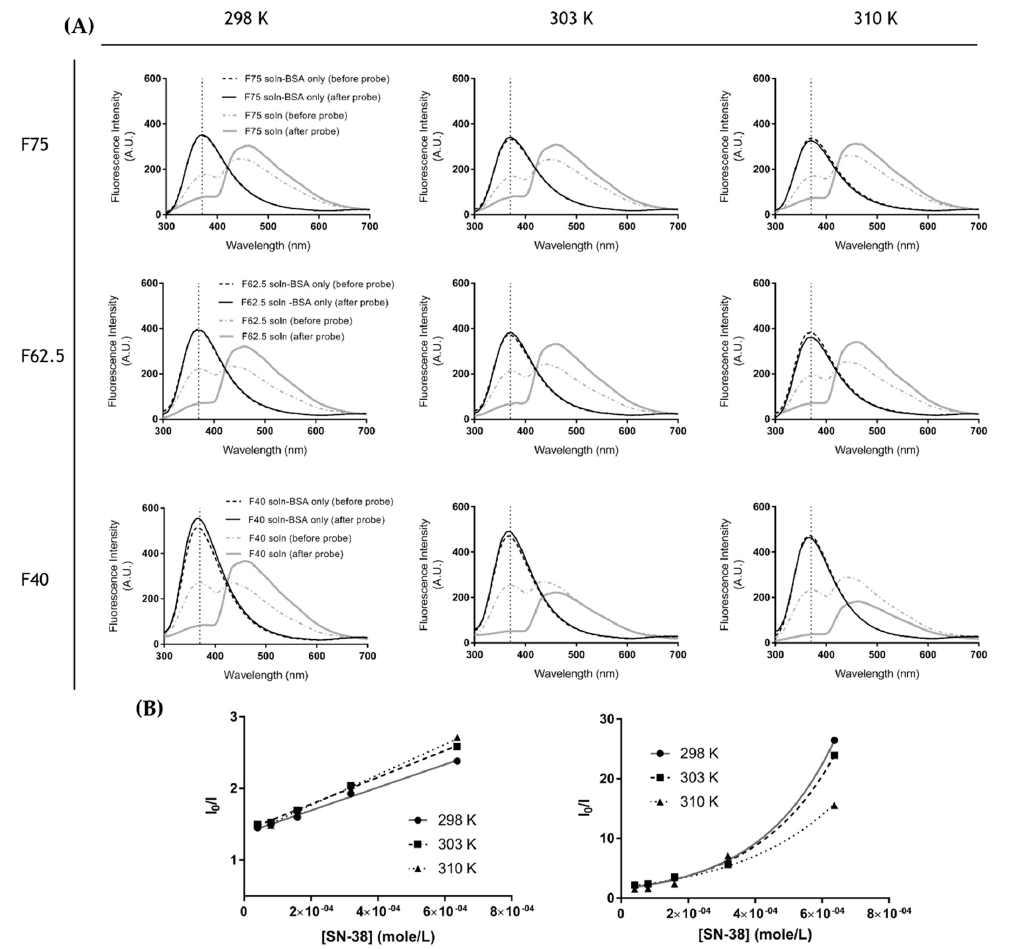
Figure 2. Protein-binding interaction: ( A ) the fluorescence quenching spectra of the BSA solution, and BSA solution with SN-38 (before/after probe sonication); ( B ) the Stern–Volmer plot for the quenching of the BSA solution with different concentrations of SN-38 (before/after probe sonication).